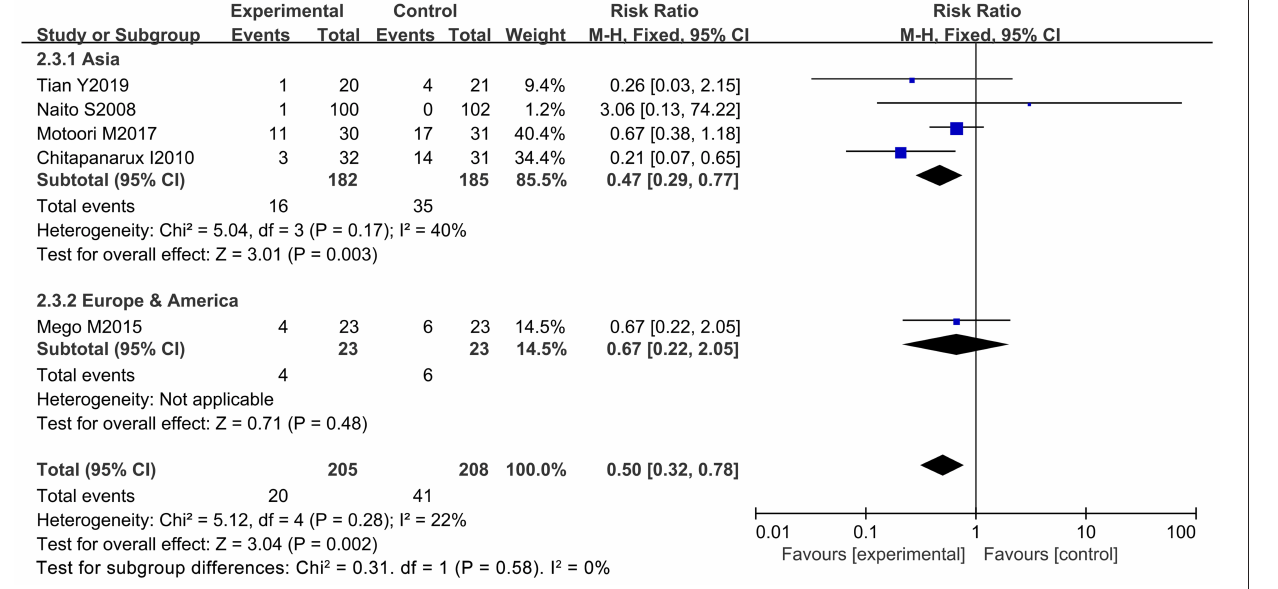
FIGURE 6 | Subgroup analysis of orally administrated probiotics for reducing severe diarrhea in cancer patients based on continental